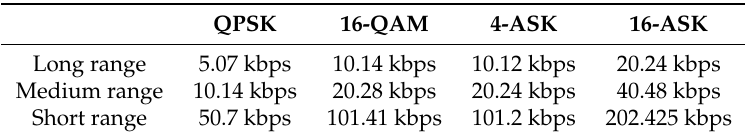
Table 2. Data rates for OFDM systems under